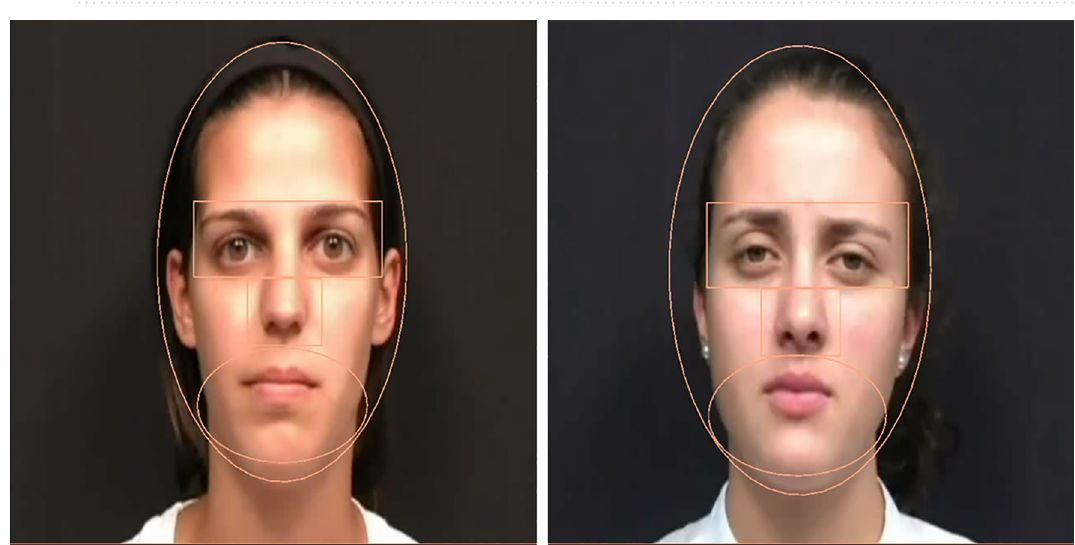
Figure 2. Example of stimuli used in Experiments 1 and 2 with AOIs for analysis overlaid. Left image is the English (native) speaker and right image is the Spanish (non-native) speaker. AOIs include the face, the eyes, and the mouth. Stimuli credit to Lewkowicz and Hansen-Tift 46